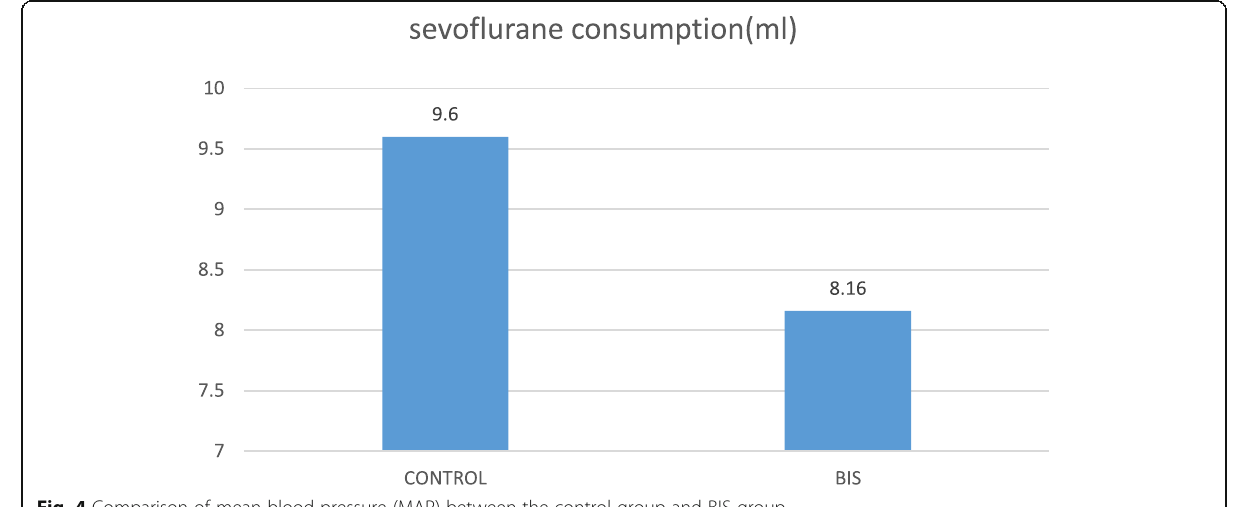
Fig. 4 Comparison of mean blood pressure (MAP) between the control group and BIS group